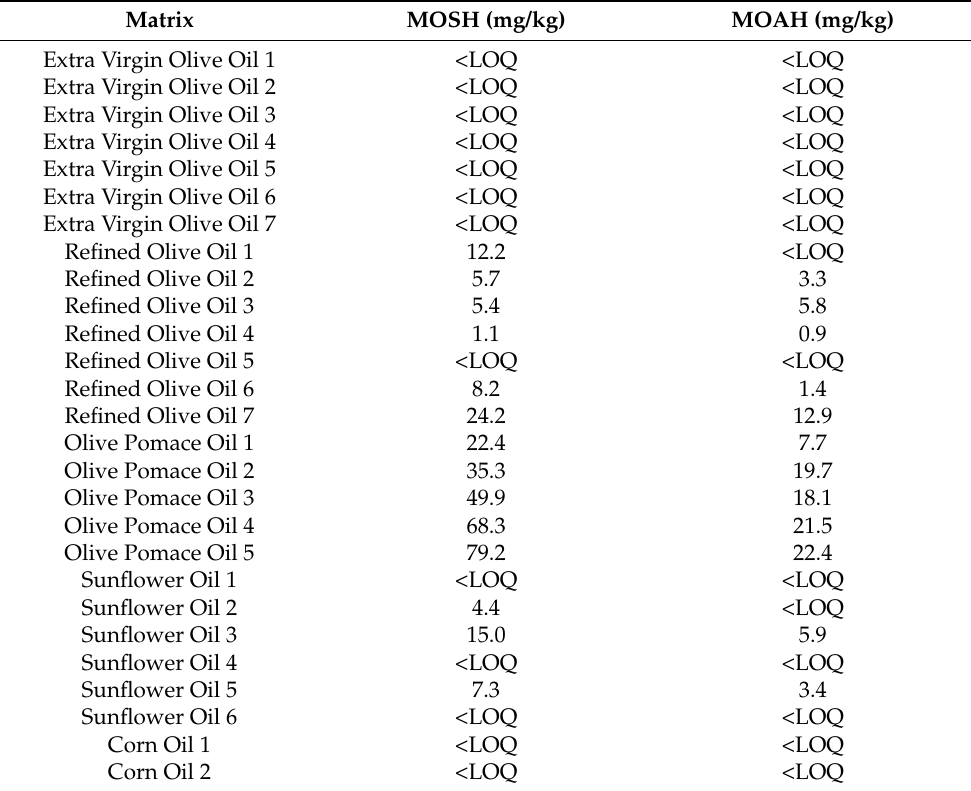
Table 2. Concentration by ranges of MOH detected in the samples of edible oils analyzed. Matrix MOSH (mg/kg) MOAH (mg/kg) Extra Virgin Olive Oil 1 <LOQ <LOQ Extra Virgin Olive Oil 2 <LOQ <LOQ Extra Virgin Olive Oil 3 <LOQ <LOQ Extra Virgin Olive Oil 4 <LOQ <LOQ Extra Virgin Olive Oil 5 <LOQ <LOQ <LOQ <LOQ <LOQ